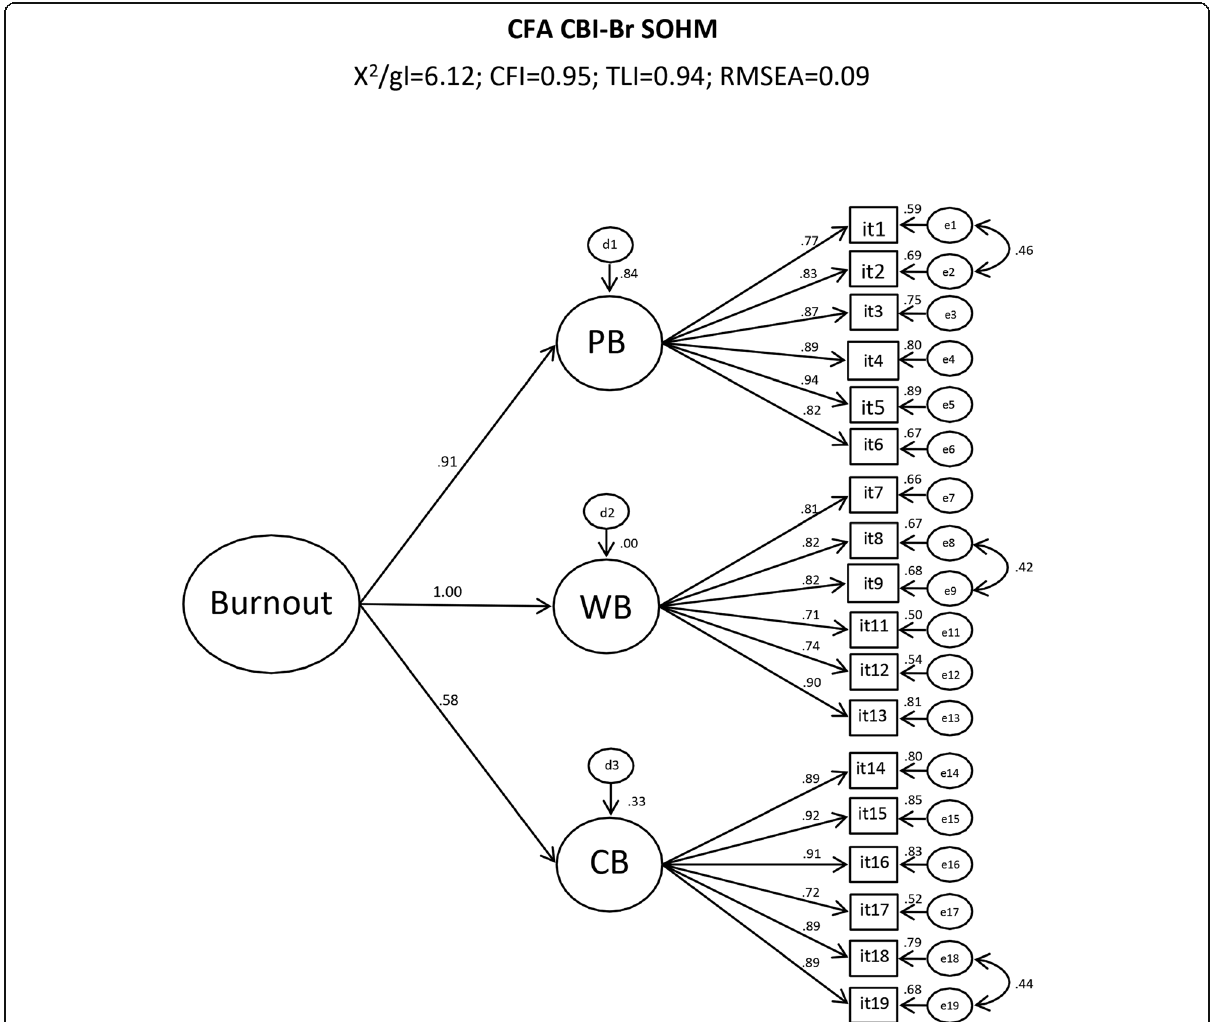
Fig. 2 Confirmatory factor analysis of CBI-Br second-order hierarchical model ( x 2 /df = 6.12; CFI = 0.95; TLI = 0.94; RMSEA = 0.09; IC90% = [0.081 – 0.093])